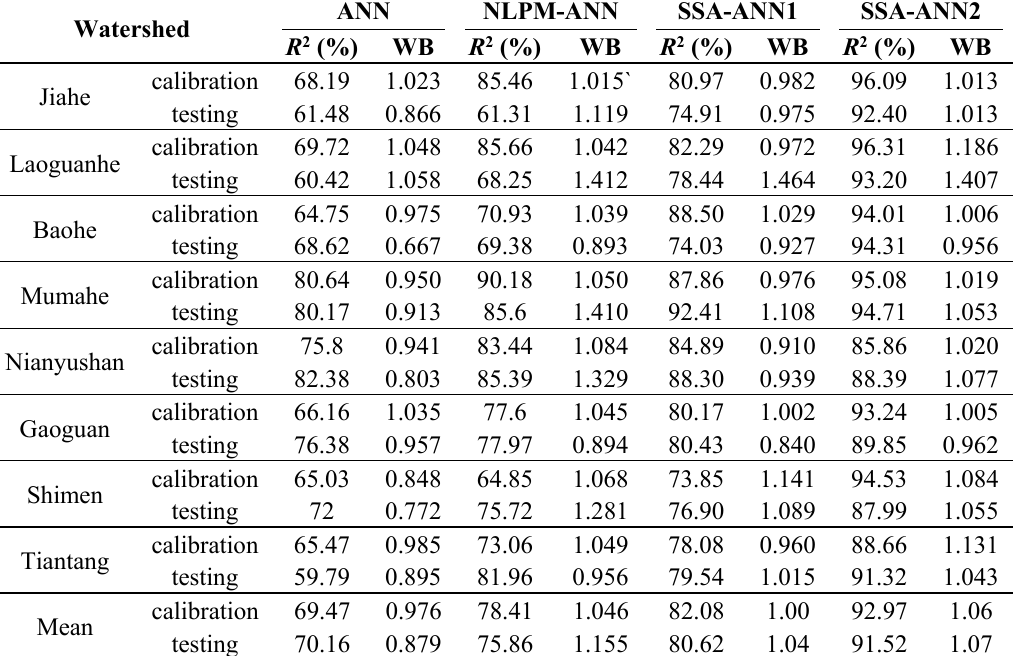
Table 3. Summary of model performances during calibration and testing